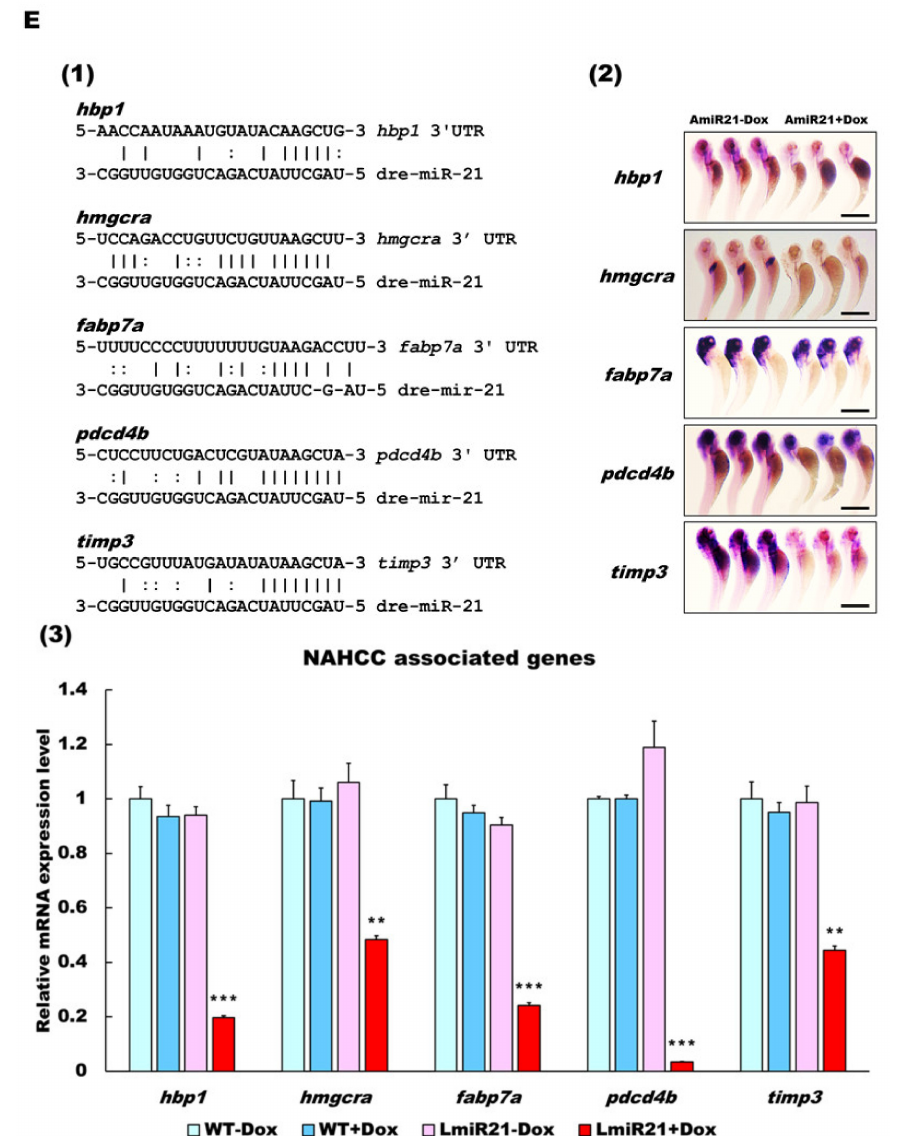
Figure 7. LmiR21 zebrafish develop nonalcoholic hepatocellular carcinoma (NAHCC) phenotypes at 10 months post fertilization (mpf). ( A ) Gross liver images from ( a ) LmiR21 − Dox male, ( b ) LmiR-21 + Dox male, ( c ) LmiR21 − Dox female, and ( d ) LmiR21 + Dox female. Scale bar: 3 mm. ( B ) Microscopic views of angiogenesis in livers from bright field: ( a ) LmiR21 − Dox ( c ) LmiR21 + Dox and corresponding GFP fluorescence images ( b ) LmiR21 − Dox ( d ) LmiR21 + Dox. Scale bar: 2 mm. ( C ) Hematoxylin & eosin stained livers from ( 1 ) LmiR21 − Dox (insets a – d ) ( 2 ) LmiR21 + Dox (insets a – d